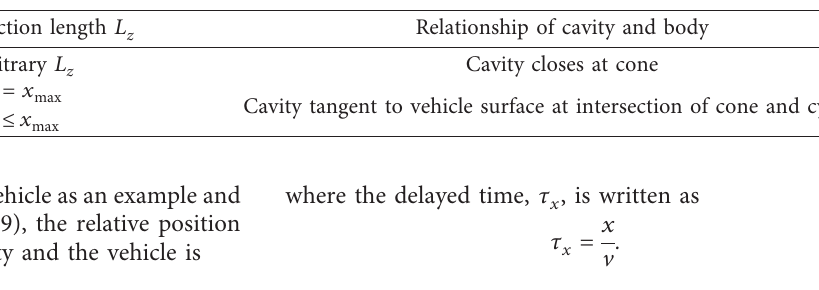
Table 1: Cavity/vehicle tangent point criteria of conical section